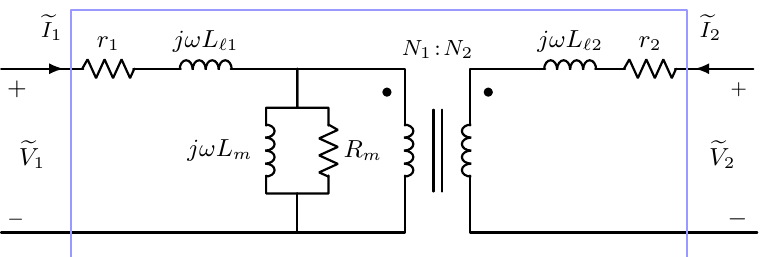
Figure 6. Equivalent steady-state circuit for a single-phase transformer. The blue box defines a two-port